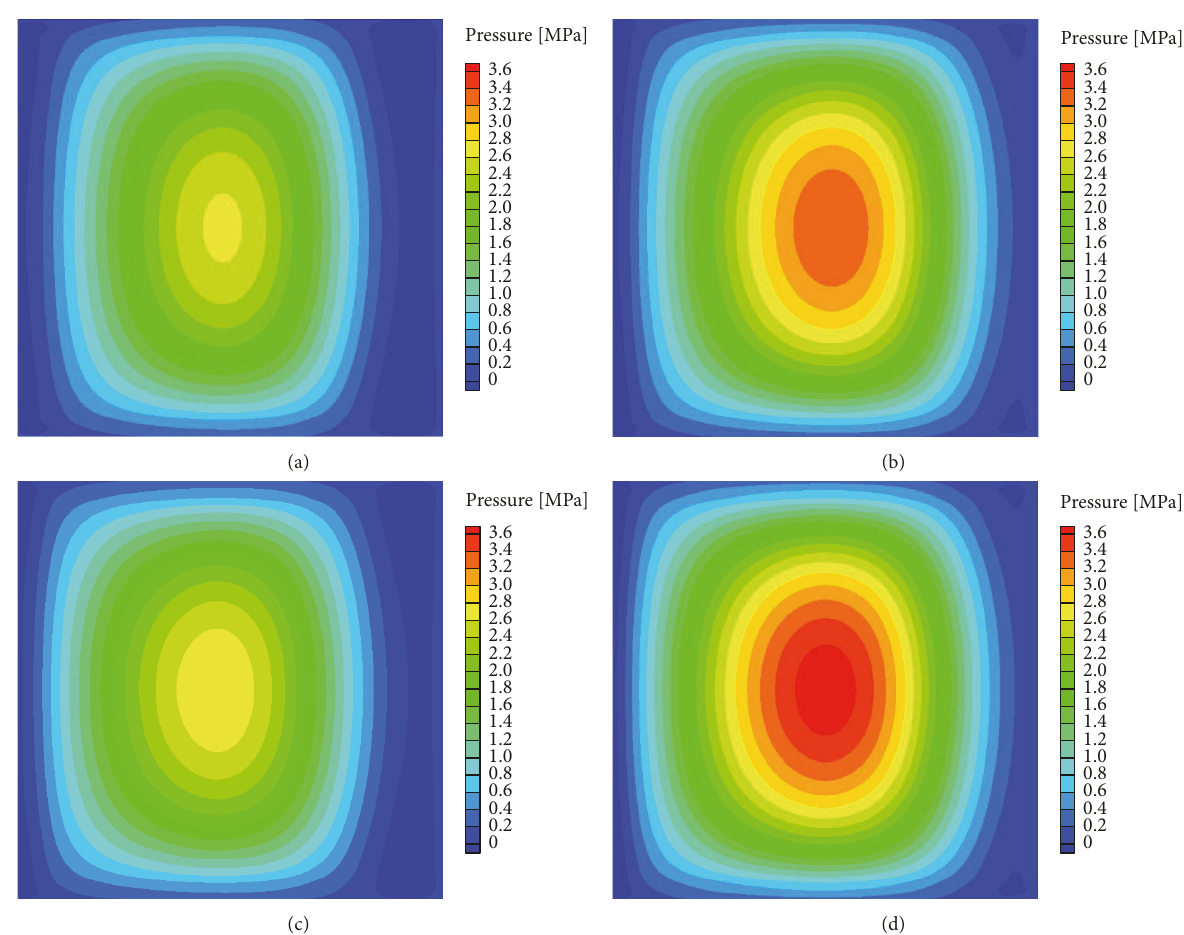
Figure 10: Contours of pad-side pressure. (a) Laminar model; (b) SA model; (c) transition SST model; and (d) SST model with low-Re correction.